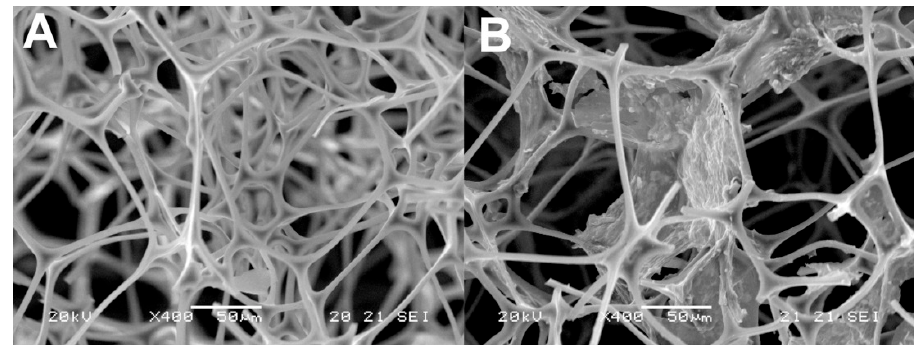
Figure 4. SEM images of MeS before ( A ) and after ( B ) functionalization with graphene (GMeS). Source: Reproduced from [10], with permission from Elsevier.